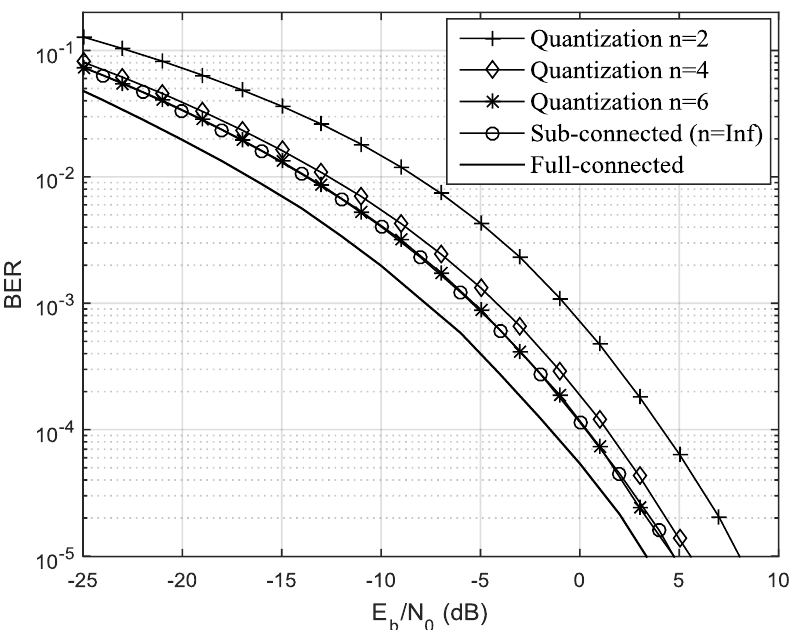
Figure 6. Performance of the proposed hybrid sub-connected scheme for different numbers of quantization bits of the average AoD, 8 U 